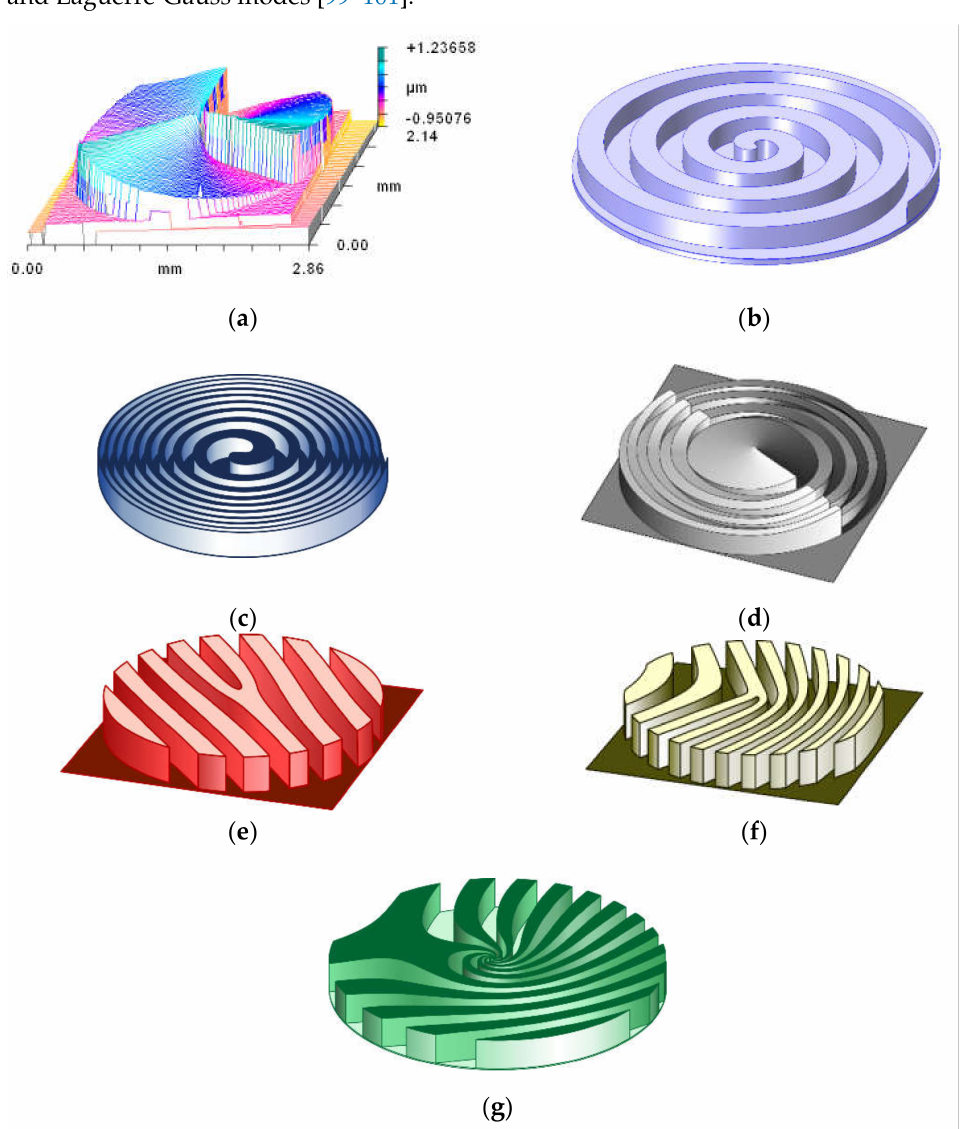
Figure 3. Elements of singular optics: ( a ) SPP. Reprinted with permission from ref. [36]. Copyright 1994, Elsevier; ( b ) spiral axicon; ( c ) spiral zone plate; ( d ) OV autofocusing optical element; ( e ) fork grating; ( f ) curved fork grating; and ( g ) grating for OV hyper-geometric laser beams